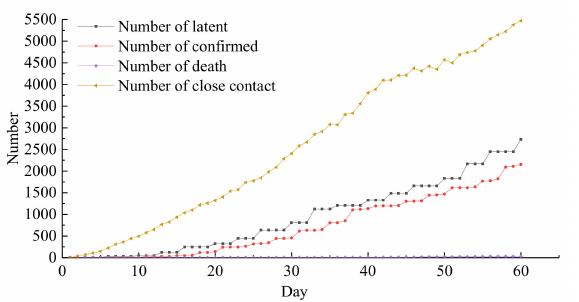
Figure 5. No-intervention scenario.